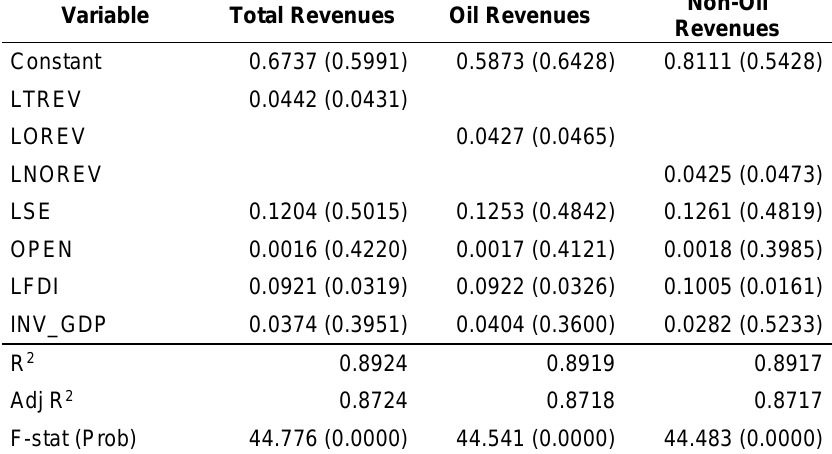
Table 8. Robustness Check Results. Dependent Variable: Industrial Production